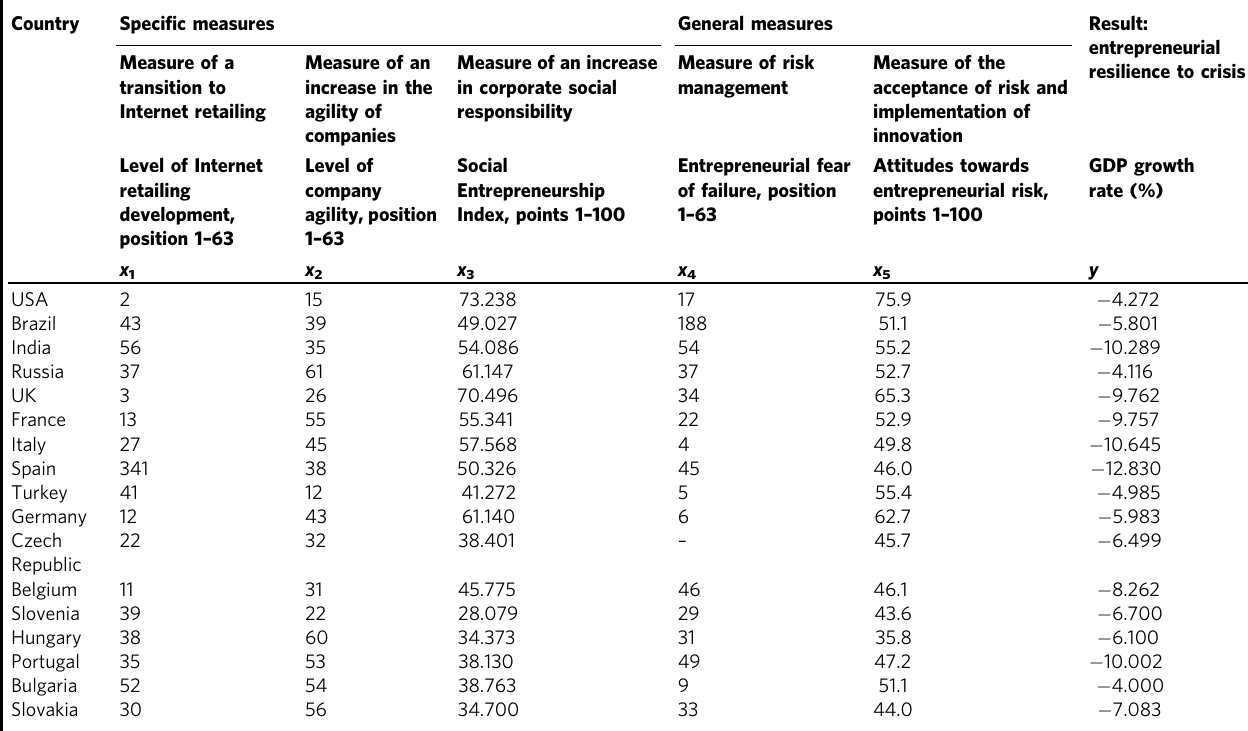
Table 1 Statistics on change management in countries with the largest number of cases and countries with the highest number of fatal cases per 100,000